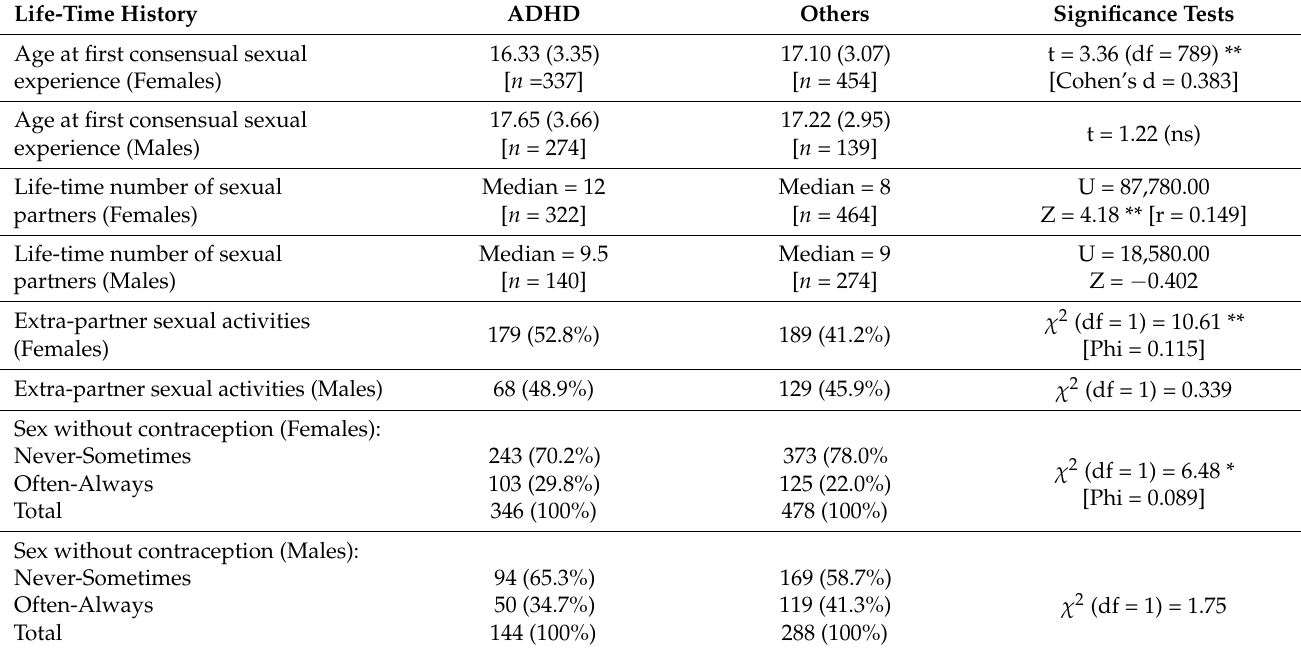
Table 6. Differences in riskier sexual history between ADHD and Other